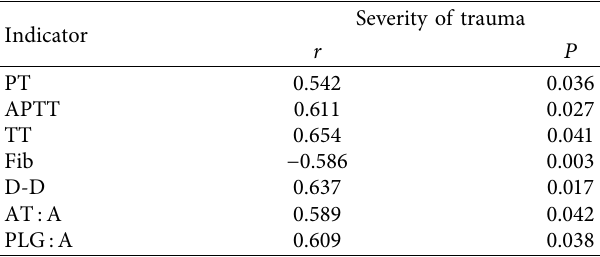
Figure 1: Comparison of serum coagulation and fibrinolysis in- dexes in each group. PT: prothrombin time, APTT: activated partial thromboplastin time, Fib: fibrinogen, TT: thrombin time, D-dimer, D-D: D-dimer, AT: A: antithrombin activity, and PLG :A: plas- Table 2: Correlation analysis between the severity of injury and coagulation and fibrinolysis indexes in patients.